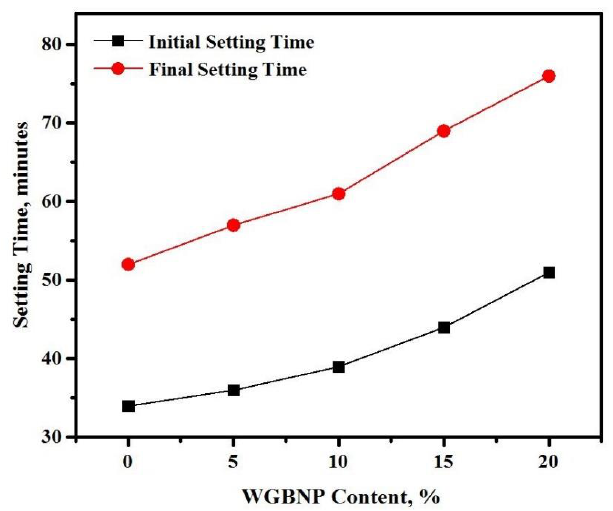
Figure 5 . Setting times of prepared AAMs .